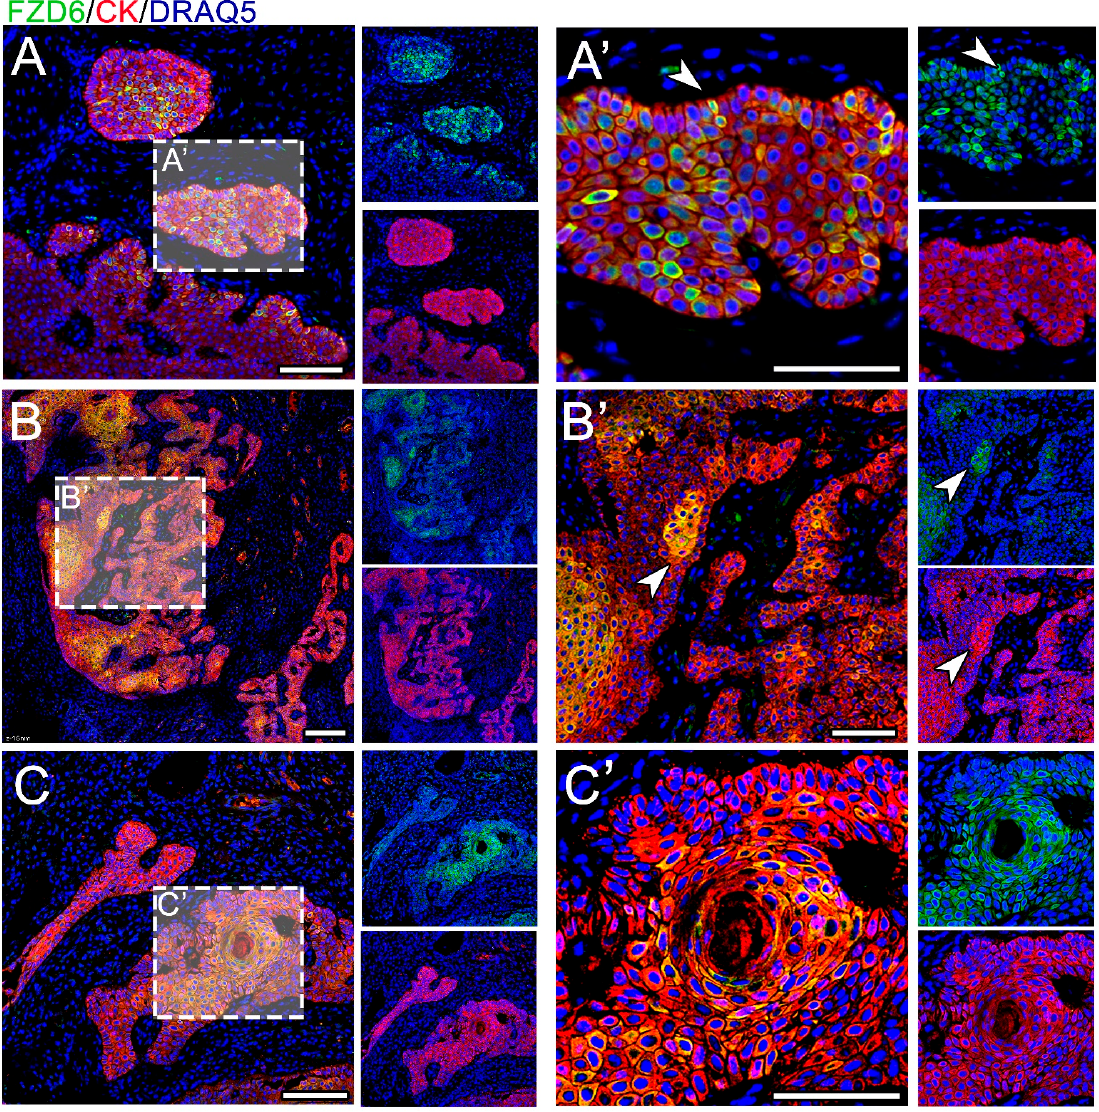
Figure 3. Expression of FZD6 in CAA. ( A – C ) The expression of FZD6 is strong and located in the cytoplasm and membranes. ( B, B’ ) The signal is mostly located in the center of epithelial tumorous tissue (arrowhead) ( A ’) but some scattered positive cells are located in the palisading outer layer of the tumorous tissue (arrowhead). ( C,C’ ) FZD6 expression is very strong in the areas of squamous metaplasia. Scale bar = 100 µm.